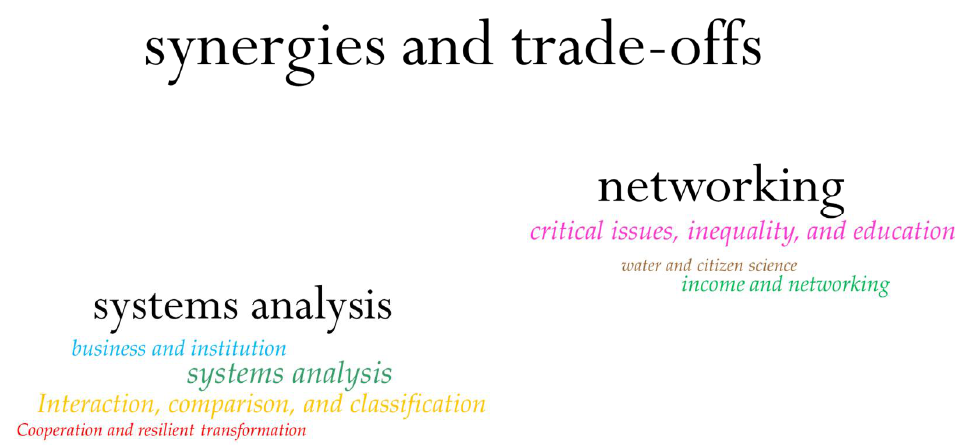
Figure 5. Theme map demonstrating the names and relative sizes of the clusters and groups, as well as the distances between them.